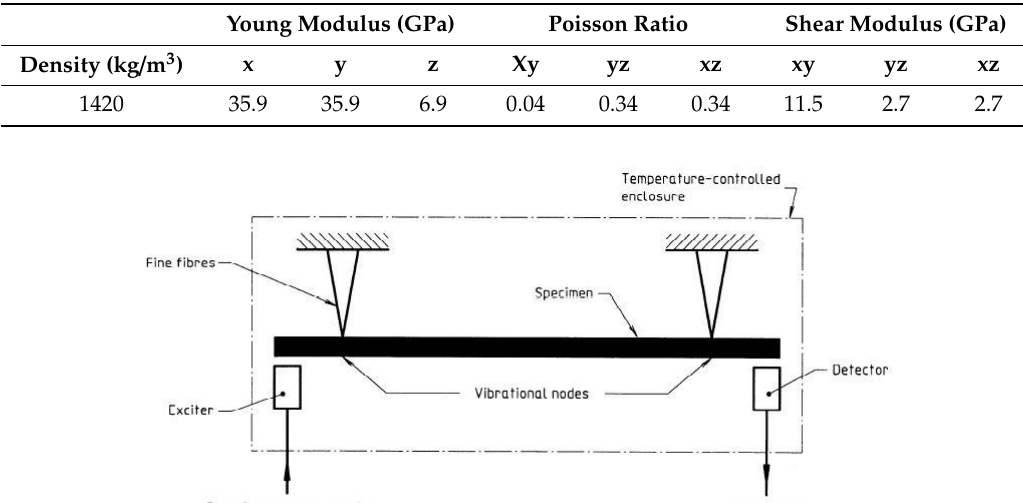
Figure 6. Experimental procedure for identifying resonance frequencies by external excitation [51] . In order to obtain experimental resonances for each plate, a wave generator was used to generate a frequency sweep for 0 < f < 2000 Hz. This sine wave was transferred to an amplifier, which sent the signal to a coil exciting one end of the plate. On the opposite side of the plate, a flat-spectrum